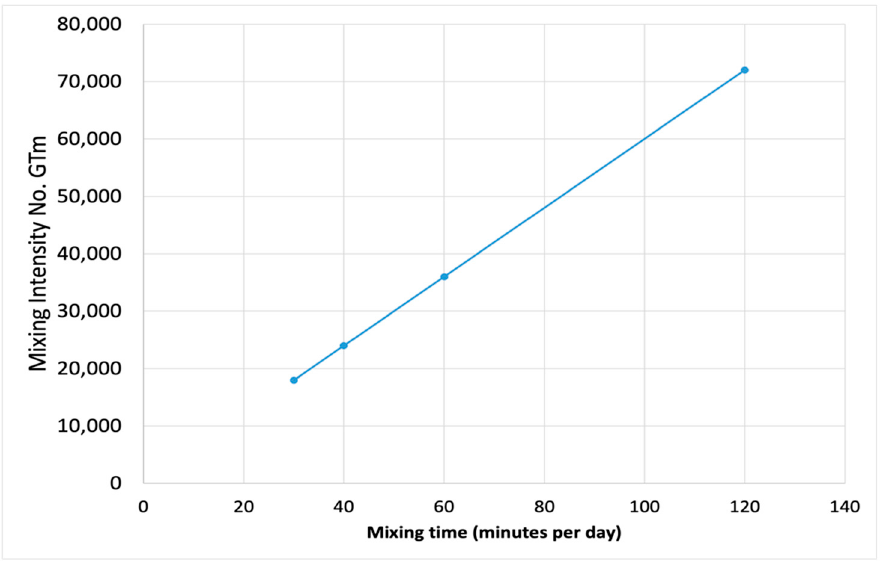
Figure 8. Relationship between mixing intensity number and mixing time. Table 6. Comparison between total biogas production and the mixing intensity